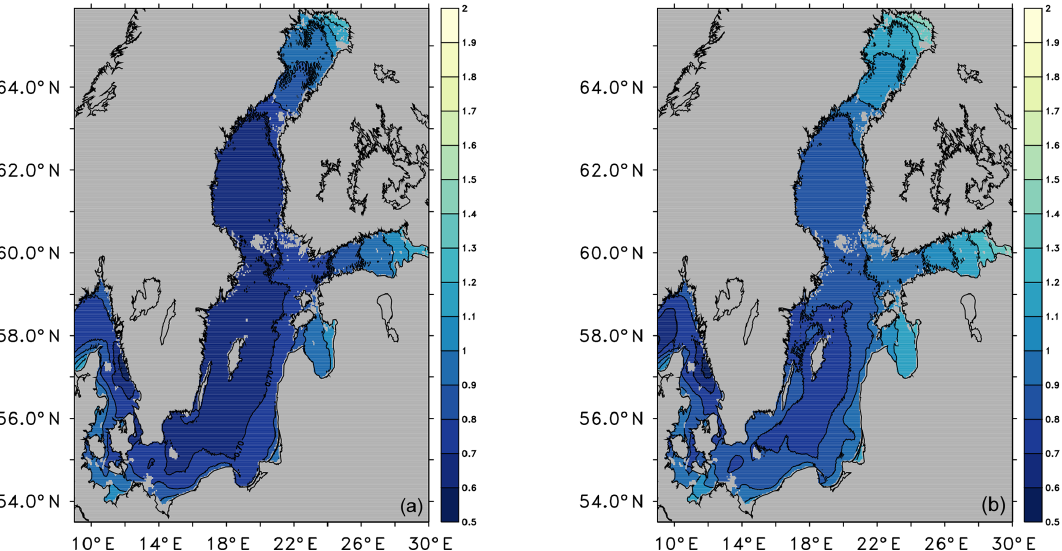
Figure 6. Ensemble median of the 99.9th percentile of ESLs (m) for the period of 1970 to 1999 relative to the mean sea surface (a) and relative to bedrock (b) .